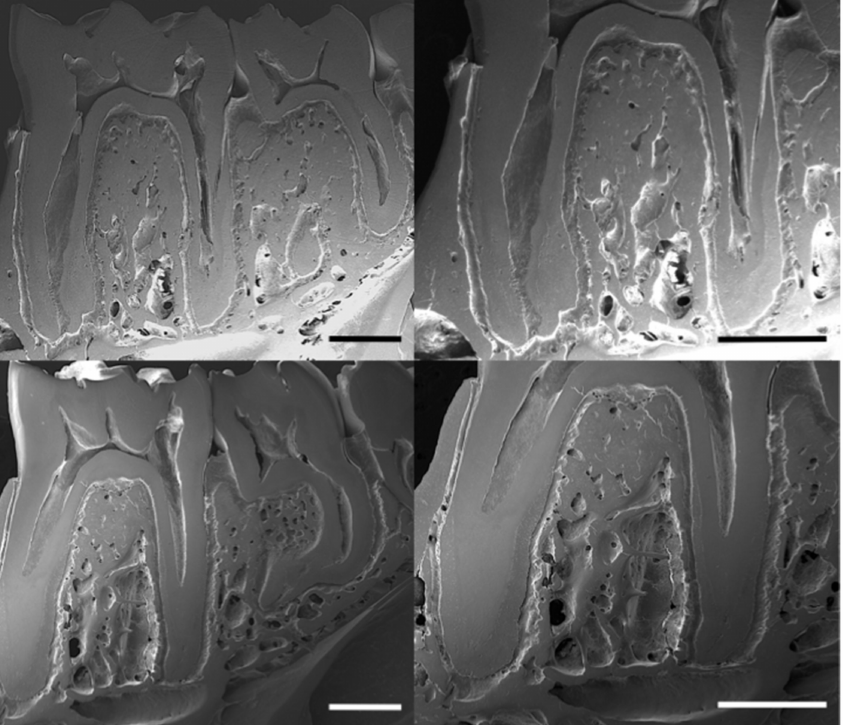
Figure 3. Scanning electron micrographs (SEM) showing the microstructural changes of alveolar bone in buccal axial cross-sections of rat mandibles in the control (upper row images) and lead-exposed (lower row images) groups. Scale bars: 1 mm.